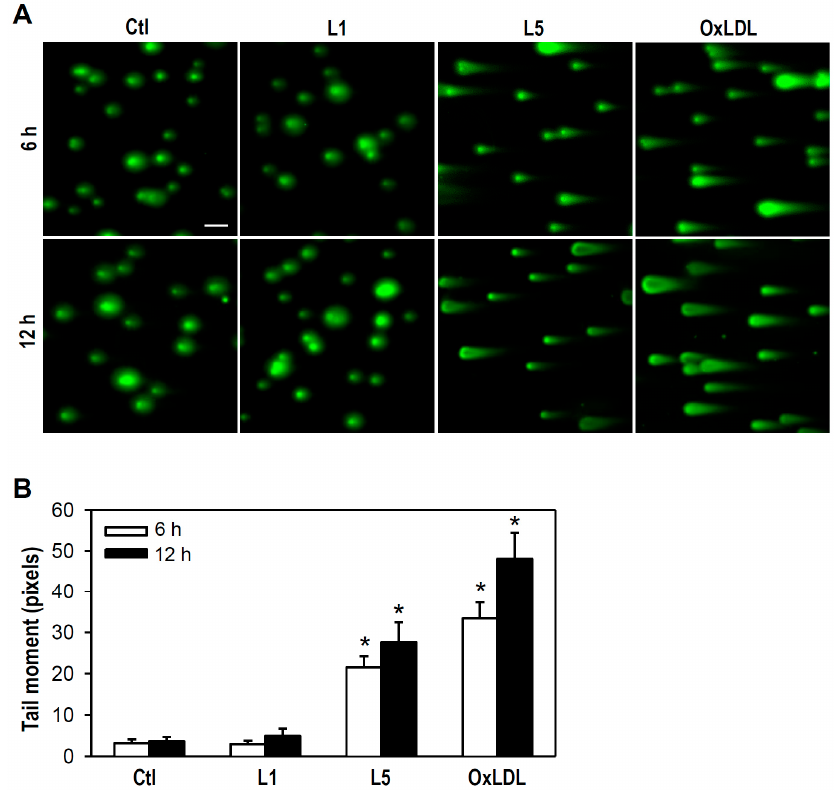
Figure 2. L5 induces DNA double-strand breaks (DSBs) in cultured PC12 cells. ( A ) Cultures treated with the indicated LDL (30 µ g/mL) for 6 or 12 h were analyzed for DSBs using a neutral comet assay kit. Untreated cells were used as a control. Representative images from one of four independent experiments are presented. Scale bar = 50 µ m; and ( B ) The comet tail moment used to determine DNA damage was quantified by COMETscore.v1.5 software. Data are presented as mean ± SEM from four independent experiments. * p < 0.05 vs. Ctl at the same time point. At least 200 cells were analyzed in each treatment group per experiment.